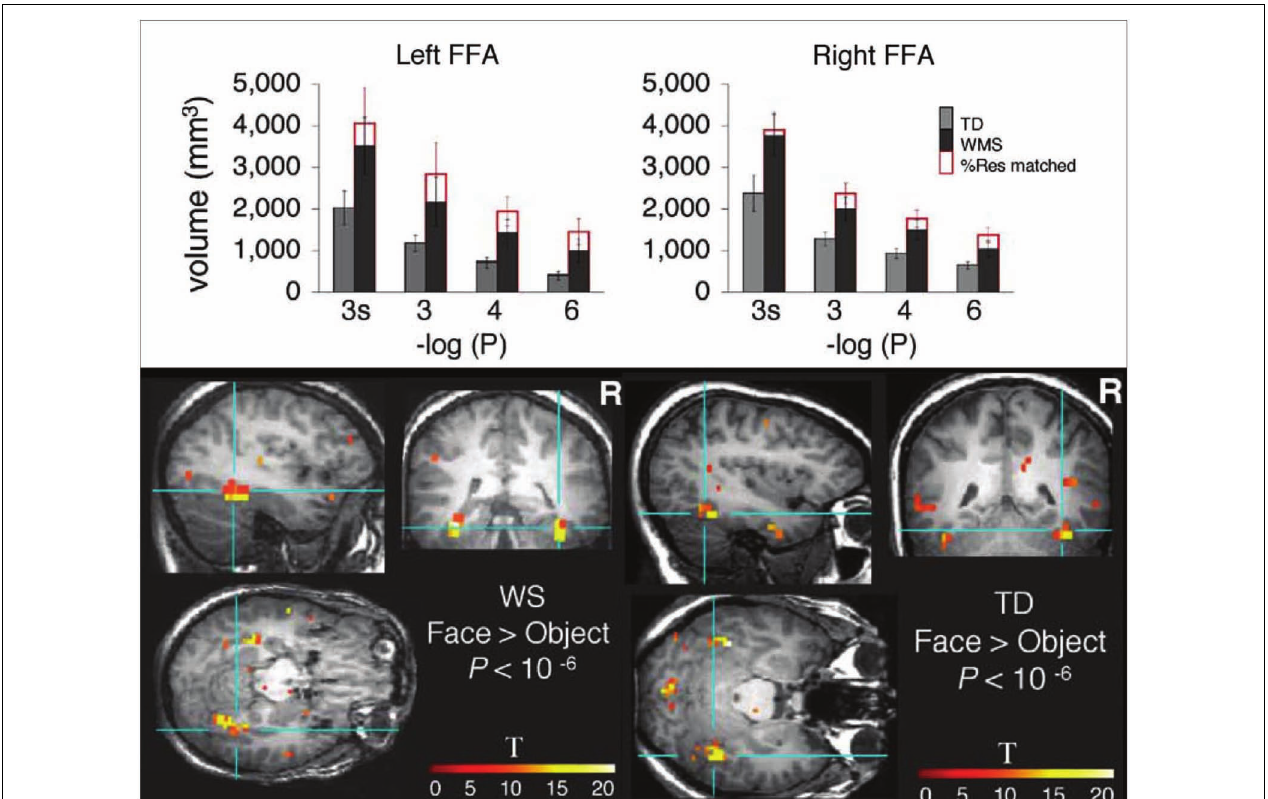
smoothing techniques. Images presented in the lower panel display an FFA defined on aWS brain (left) and aTD brain (right). Adapted from Golarai et al. (2010a) the Journal of